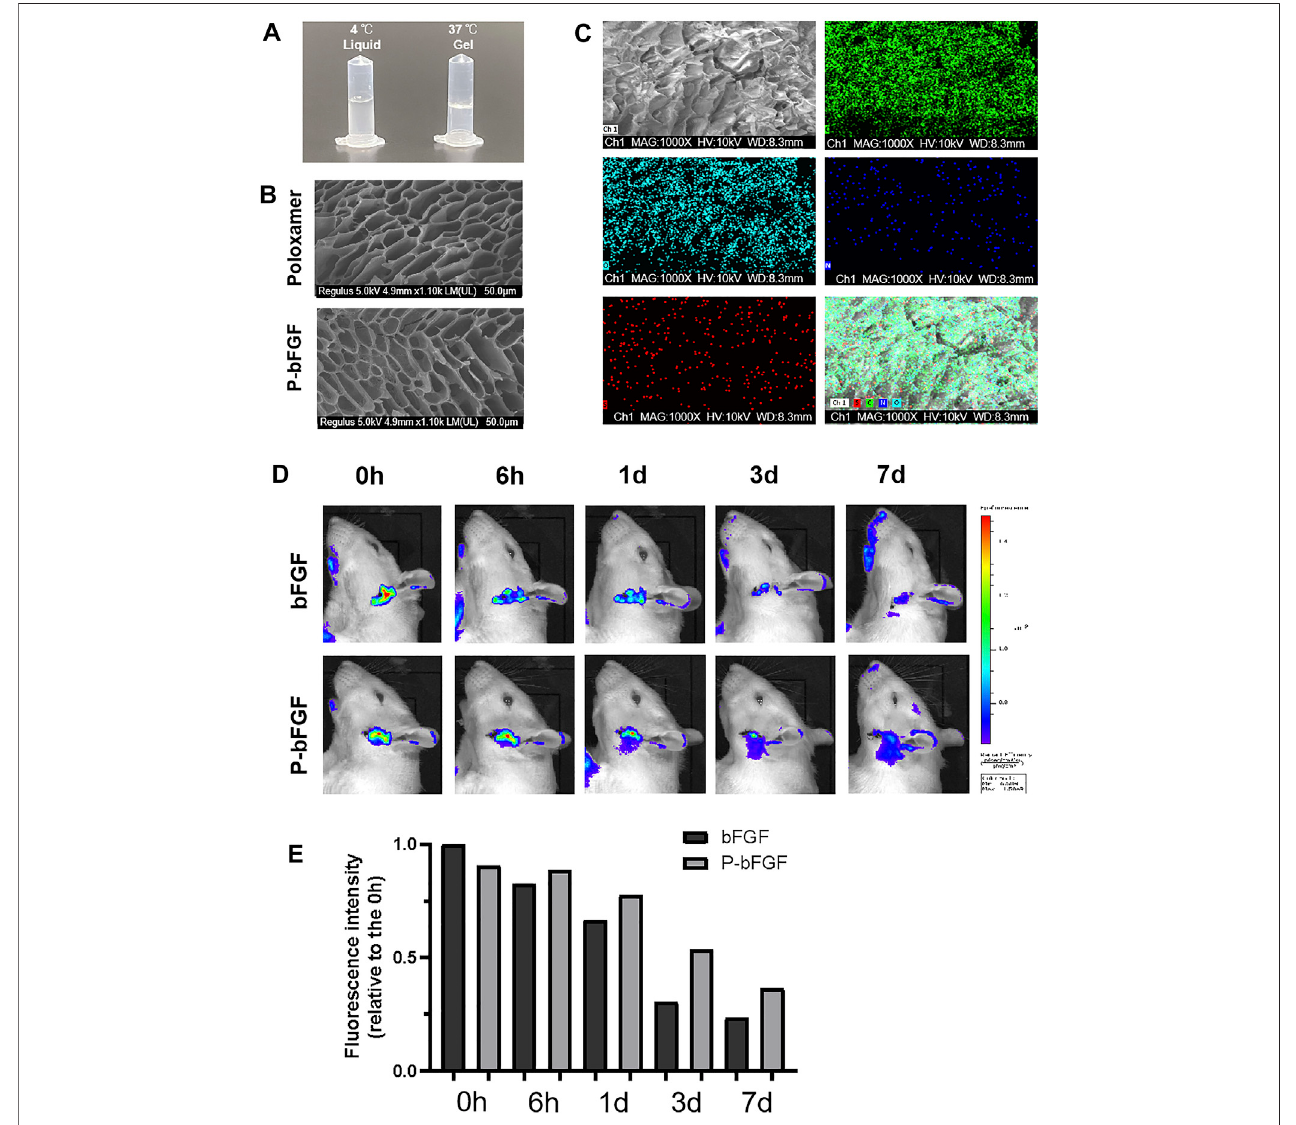
FIGURE 1 | Thermosensitivity, microstructure, relevant element analysis and in vivo local residence time of P-bFGF hydrogel. (A) The state of P-bFGF at 4 and 37 ° C. (B) The SEM image of poloxamer and P-bFGF hydrogel morphology; scale bar = 50 μ m. (C) The SEM-EDS image analysis of P-bFGF hydrogel morphology. Channel 1 (Ch1), Channel C, Channel O, Channel N and Channel S were merged as one Channel. Scale bar = 50 μ m. (D) Representative bioluminescence imaging of rats in different treatment groups at different times. (E) Quantitative calculation of the luminous intensity.